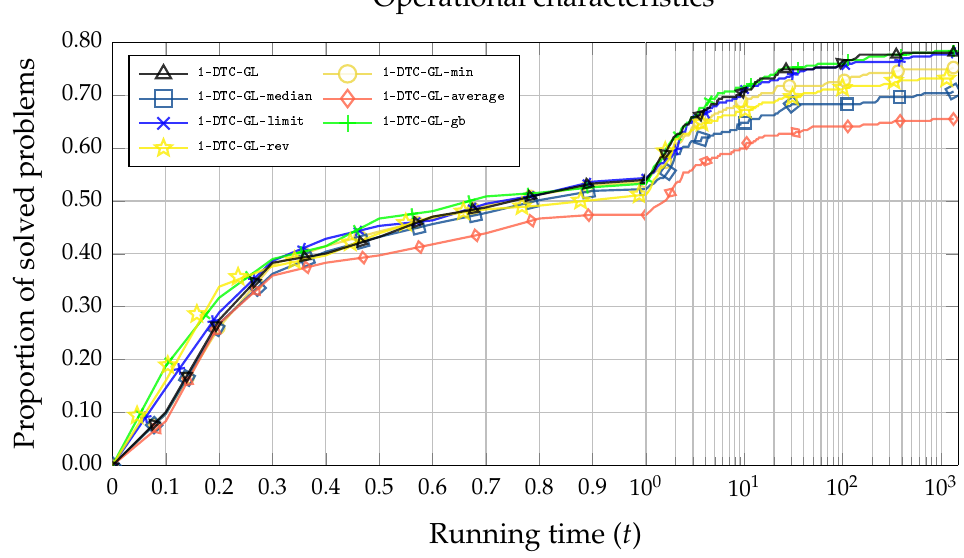
Figure 6. Operational characteristics based on the execution time in seconds for all seven 1-DTC-GL algorithmic variations on the whole set of DIRECTGOLib v1.2 test